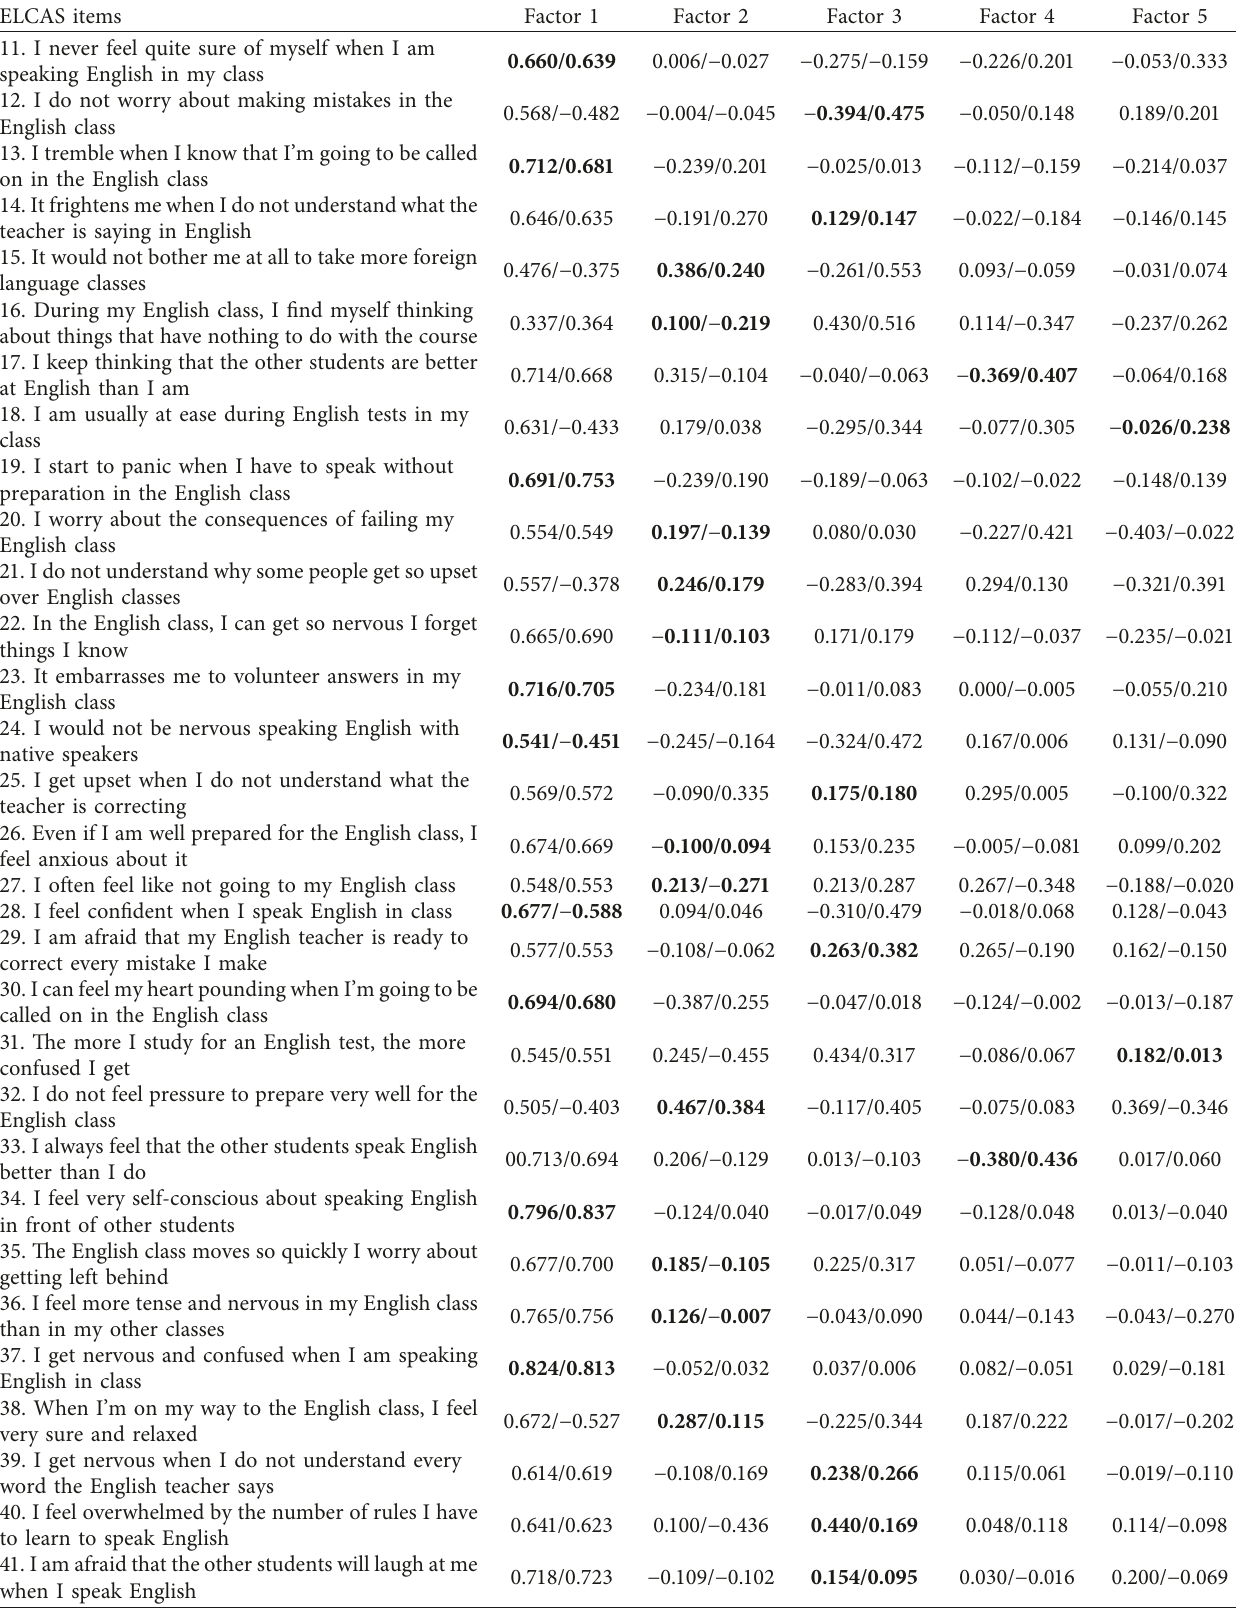
Table 1: Loadings of principal components of ELCAS (phases 1/2) ( N �